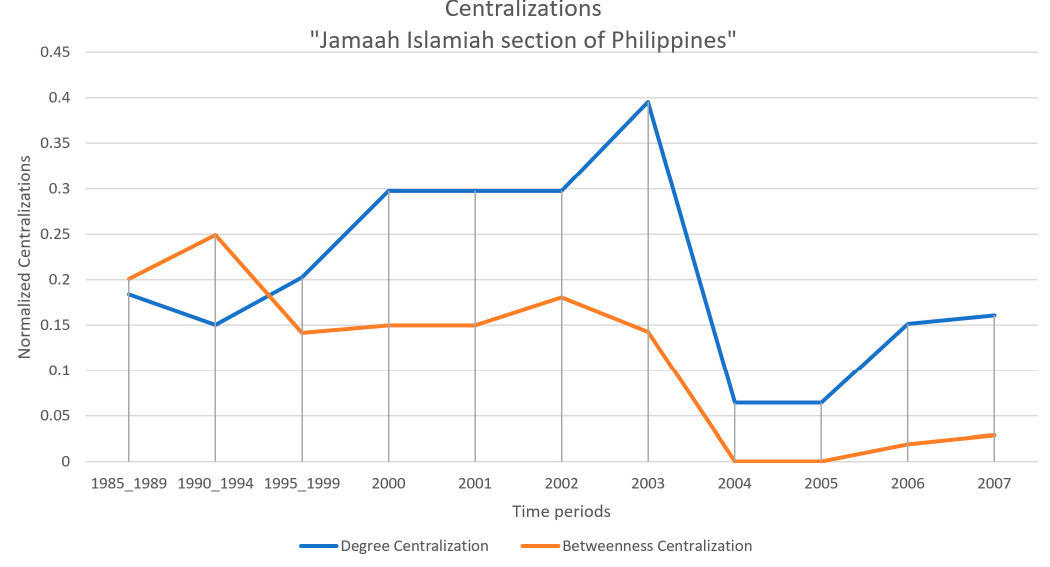
Figure 12. Temporal development of degree and betweenness centralizations for the “Jamaah Islamiah section of Philippines”. Both indices fluctuate. Betweenness centralization increases to a maximum in 1994, then decreases up to 1999, before increasing again till 2002, and afterwards it rapidly decreases till 2004. Degree centralization increases from 1994 to 2000, then reaches a plateau at 2002, and afterwards it rapidly decreases up to 2004. Both indices slowly increase after 2005, without reaching their previous values.